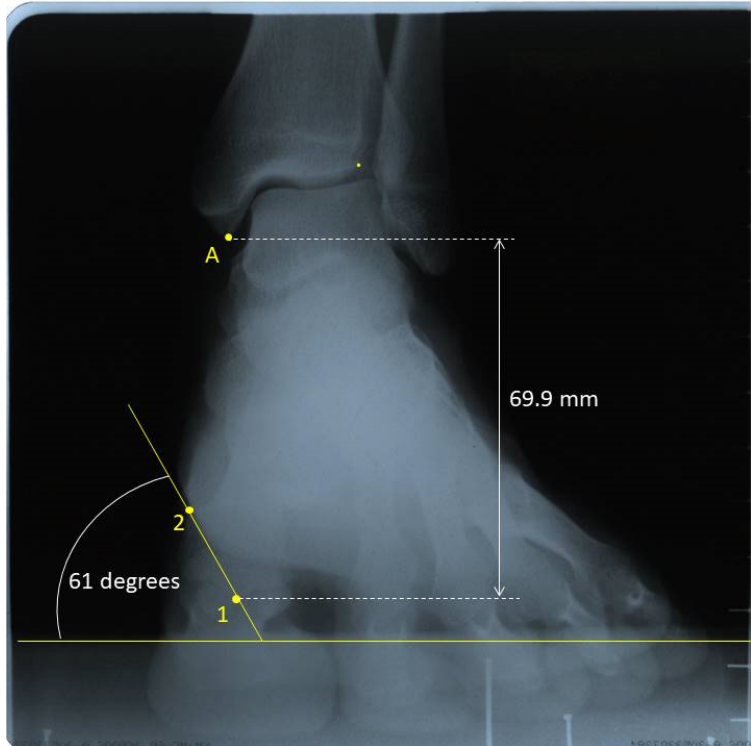
Figure 3. Radiographic measurements in one foot with first ray in neutral position. Point 1: intersesamoid crest; Point 2: superomedial tubercle of the first metatarsal head. Point A: the most distal tip of the tibial malleolus.